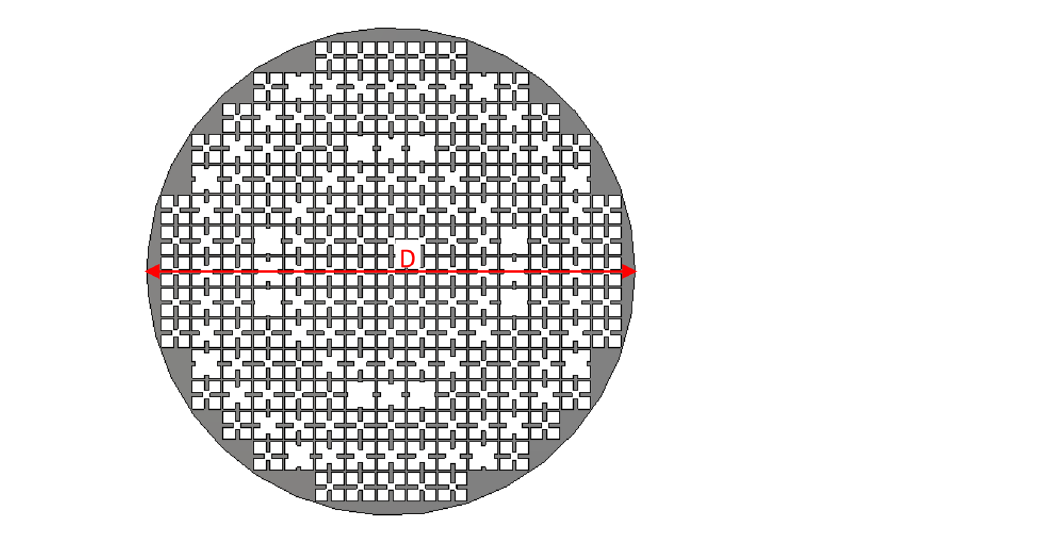
Figure 7. The schematic of the simulated transmitarray structure.